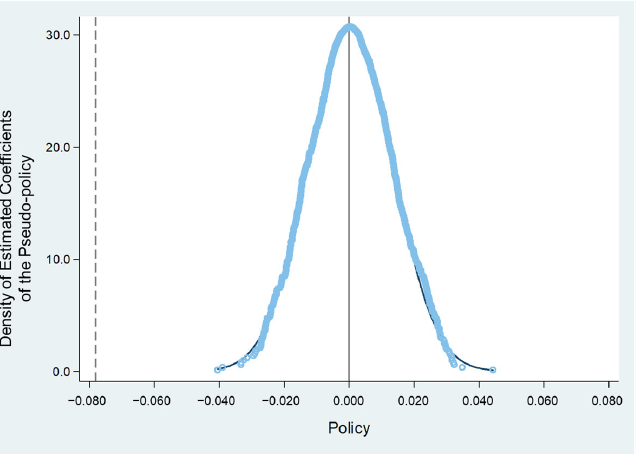
Figure 3. Result of the placebo test. The vertical axis is the density of estimated coefficients of the corresponding pseudo ‐ policy. The blue holly circle represents the distribution of the pseudo ‐ policy coefficients. The grey dashed line marks the estimated coefficient in the baseline regression. The grey line is the zero value of the pseudo ‐ policy coefficients.